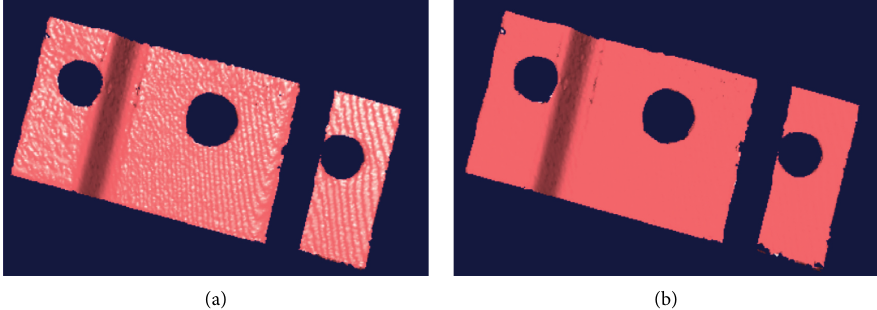
Figure 12: 3D reconstructions of the aluminum material. (a) Three-frequency with four phase shifts. (b) Our proposed method. Table 3: Evaluation and analysis of point cloud by the traditional phase-shifted method for Figure 12(a). Direction Maximal value (mm) Average error (mm) Standard deviation (mm) Negative direction − 3.8620 − 0.7231 Absolute direction 3.8620 0.0159 Forward direction 3.3378 Table 4: Evaluation and analysis of point cloud by our proposed method for Figure 12(b). Direction Maximal value (mm) Average error (mm) Standard deviation (mm) Negative direction Absolute direction 3.8603 0.0027 0.1010 Forward direction 3.6375 0.0013